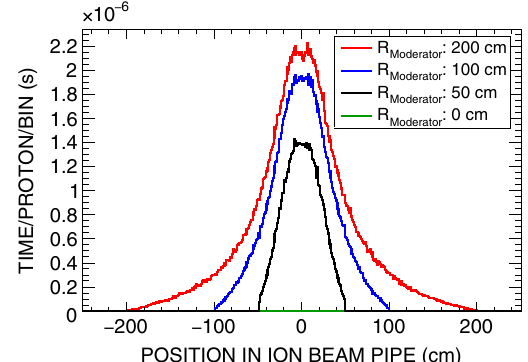
FIG. 9. The total time period neutrons spend inside the ion beam pipe as a function of position along the ion beam for different moderators, the small tungsten target and 800 MeV protons. Each entry corresponds to the sum of neutrons weighted with the time period the neutron has spent inside the tube. The x-axis has a bin width of 1 cm.